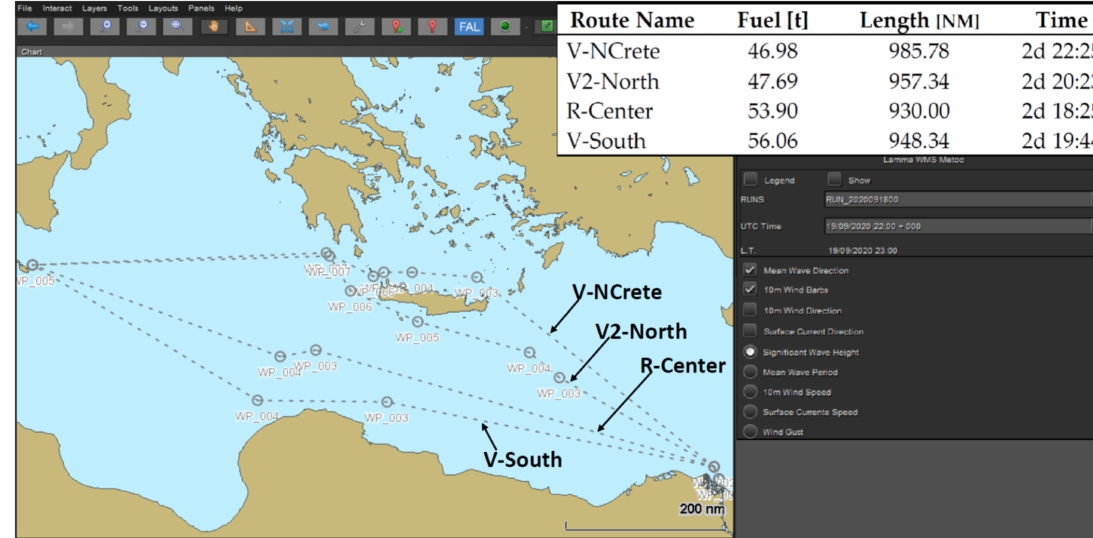
Figure 13. New analysis of four alternative routes from Port Said to La Valletta. The central route and the southern variation as before. The northern variation and the new one passing North of Crete are new variations. In the top right panel, the Routes sorting table is shown with fuel consumption estimates for these four routes. The Time column shows voyage duration in days, hours, and minutes (<days>d